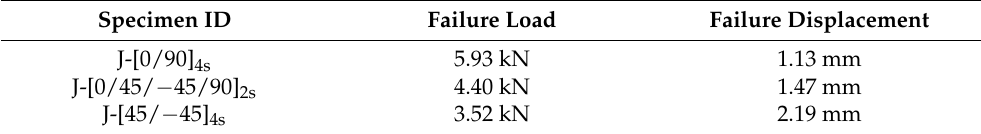
Table 4. Failure loads and displacements of the joints.